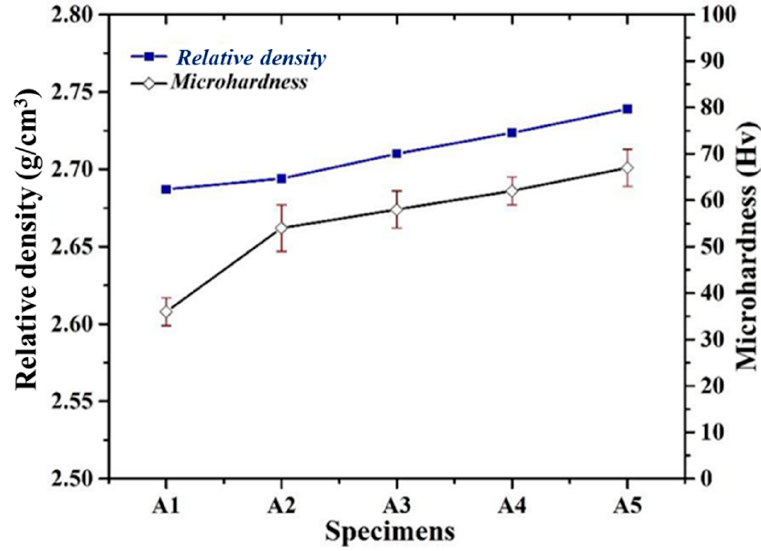
Figure 6. The variation of relative density and hardness of Al-SiC-ZrO 2 nanocomposites with different wt.% of ZrO 2 .